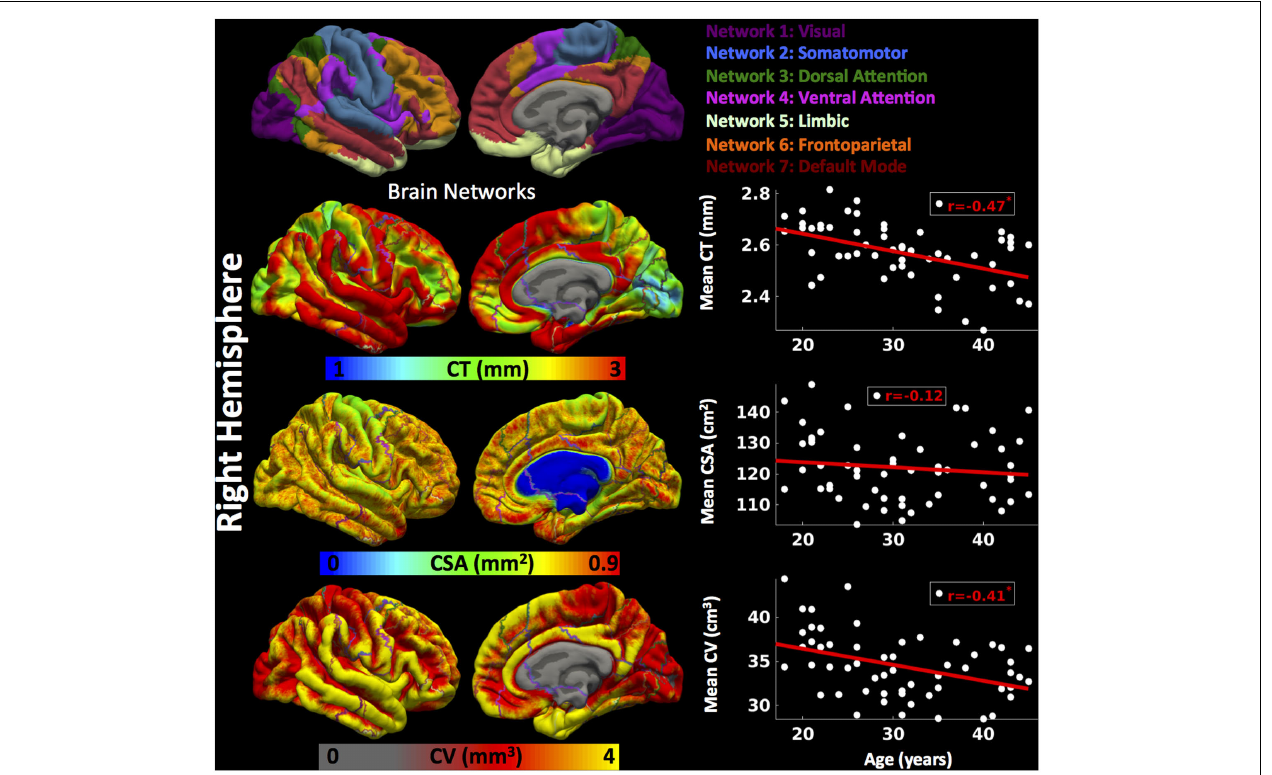
FIGURE 4 | Brain parcellation and age-related changes in mean cortical measures for right hemisphere. Right hemispheric brain parcellation into seven functional networks and vertex-wise maps for cortical thickness (CT in mm), cortical surface area (CSA in mm 2 ) and cortical volume (CV in mm 3 ). Linear plots showing age-related significant reduction in mean CT (in mm), non-significant reduction in mean CSA (cm 2 ) and significant reduction in mean CV (cm 3 ) over right hemisphere.